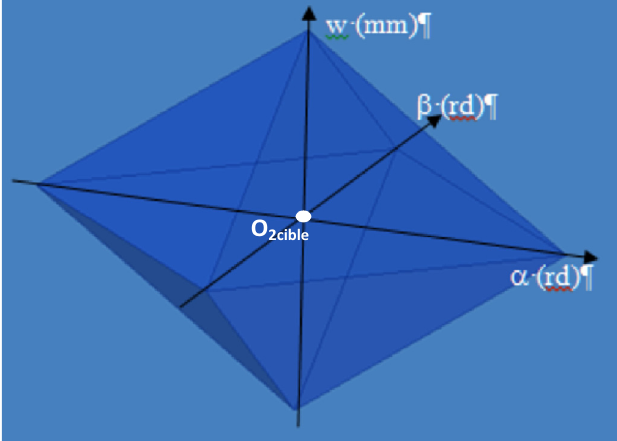
Fig. 6. The shape of the area